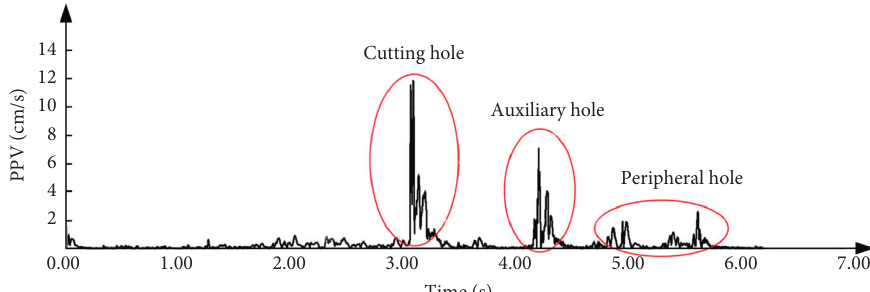
Figure 3: Time chart of vibration speed monitoring by the right wall of the first